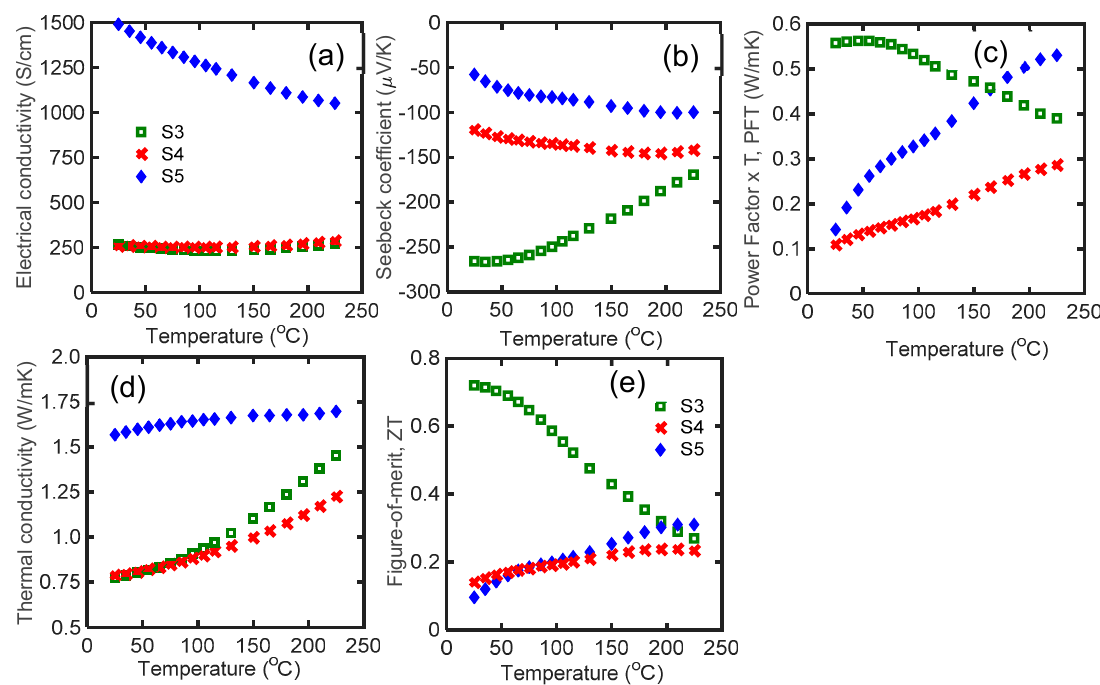
Figure 3. ( a ) Electrical conductivity; ( b ) Seebeck coefficient; ( c ) power factor × temperature; ( d ) thermal conductivity; and ( e ) zT of S3, S4, and S5 samples as a function of temperature in the range of 25 °C to 225 °C. The compositions of S3, S4, and S5 are Bi 2.00 Te 2.70 Se 0.3 , Bi 2.04 Te 2.66 Se 0.3 , and Bi 2.15 Te 2.55 Se 0.3 , respectively.